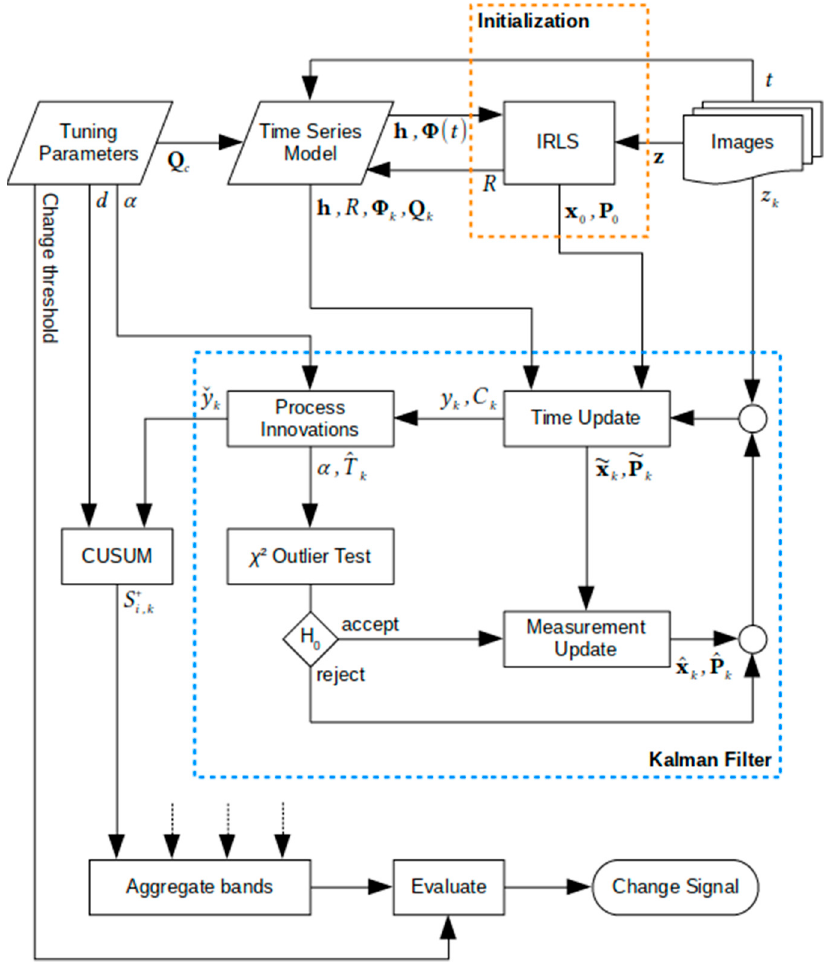
Figure 3. Flow chart of the Kalman filter approach.